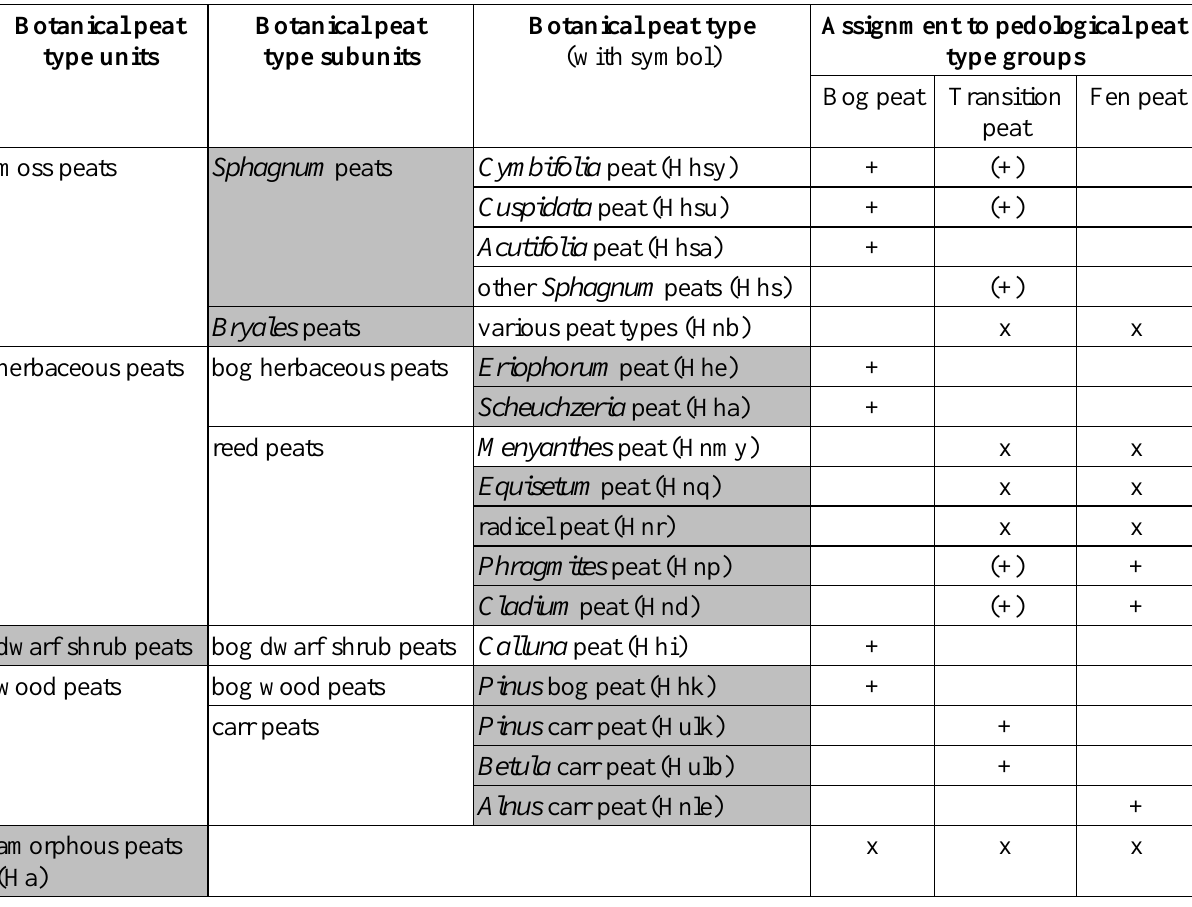
Table A1.2. Peat classification from the latest German soil mapping manual KA5 (Ad-hoc-AG Boden 2005), slightly modified and translated from German, compared to the peat types included in our key and portraits (grey).